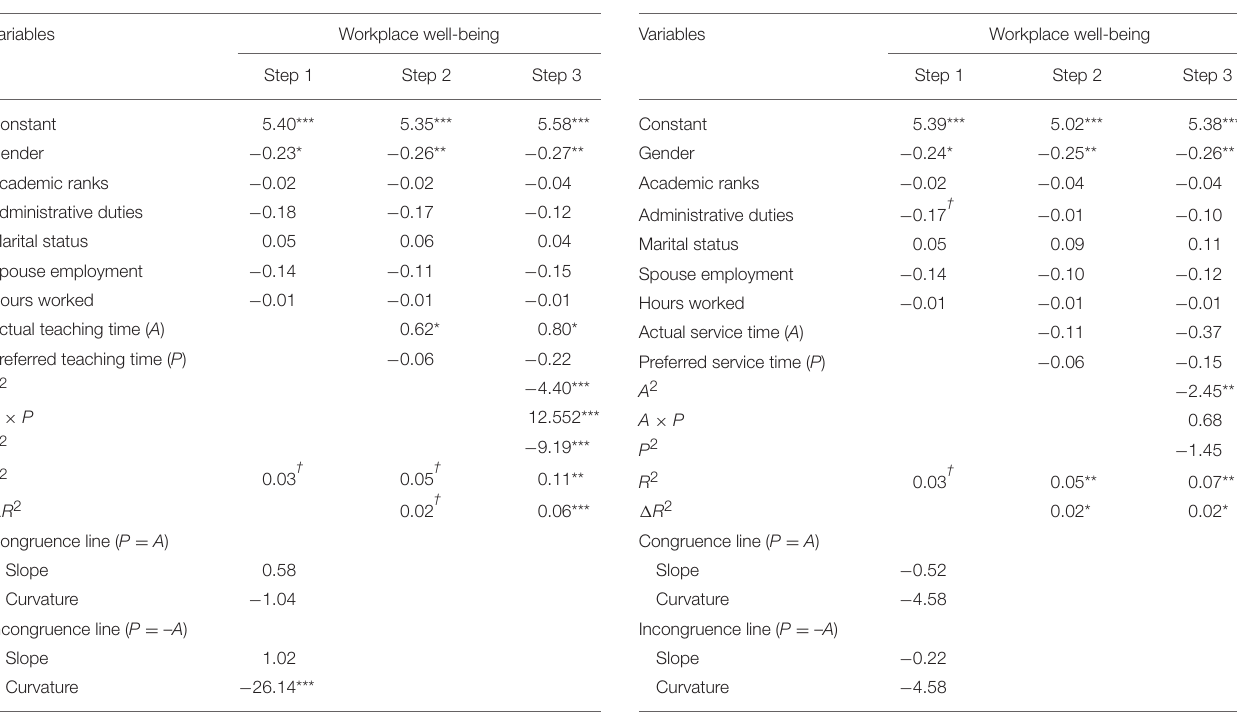
TABLE 6 | Polynomial regressions of workplace well-being on service time